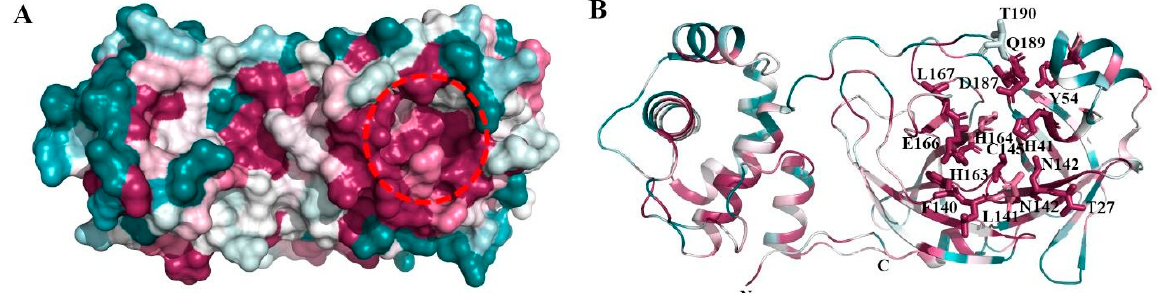
Figure 2. Consurf analysis of M pro structure: ConSurf analysis showing conserved regions in the three-dimensional structure of M pro . ( A ) Surface view showing the highly conserved substrate-binding site (red broken circle) and region involved in homodimerization (broken blue circle). Drugs were docked in the substrate-binding region of M pro . ( B ) Cartoon representation showing the conserved regions in M pro . The residues forming the substrate-binding pocket are shown in stick representation.